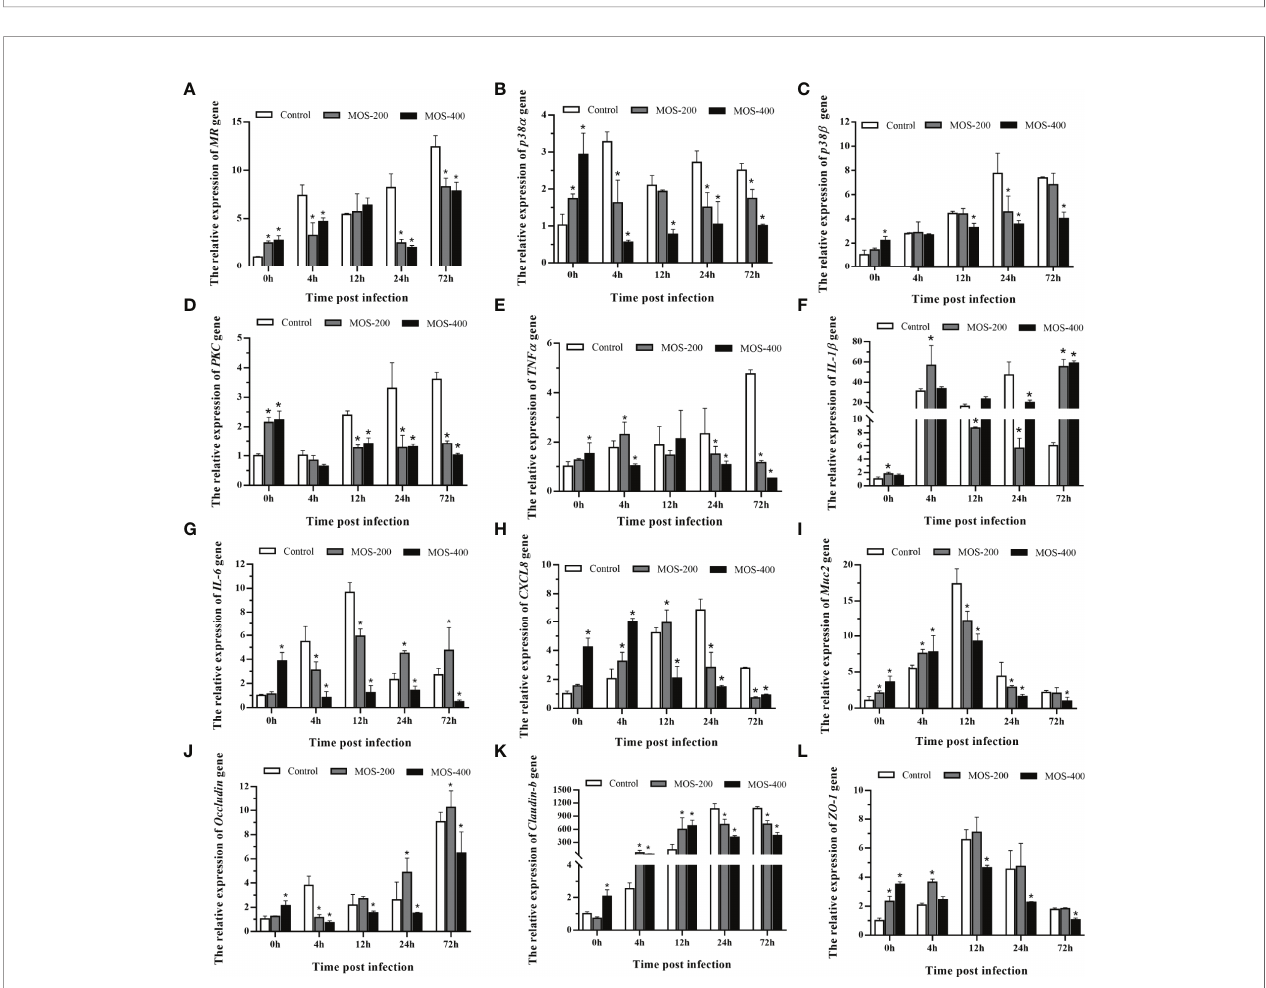
FIGURE 6 | Expression patterns of M. amblycephala intestinal immune and tight junction related genes in the three groups upon infection. The detected genes including MR (A) , p38 a (B) , p38 b (C) , PKC (D) , TNF a (E) , IL-1 b (F) , IL-6 (G) , CXCL8 (H) , Muc2 (I) , Occludin (J) , Claudin-1 (K) , and ZO-1 (L) , and GAPDH was selected as the reference gene. Data were shown as mean ± SE, differences were determined by one-way analysis of variance (ANOVA). The asterisks indicated statistically signi fi cant differences among different groups at a certain time point ( P <